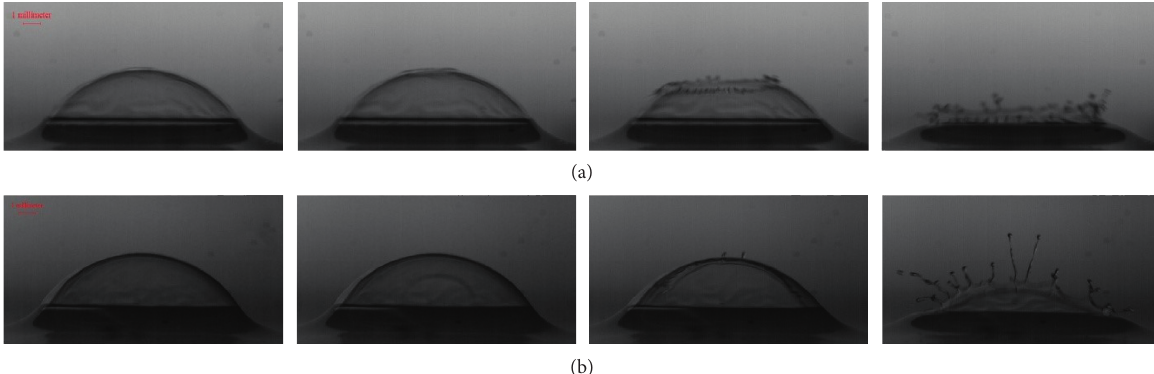
Figure 4: Visualization of bubbles bursting at different locations: (a) top and (b) bottom.